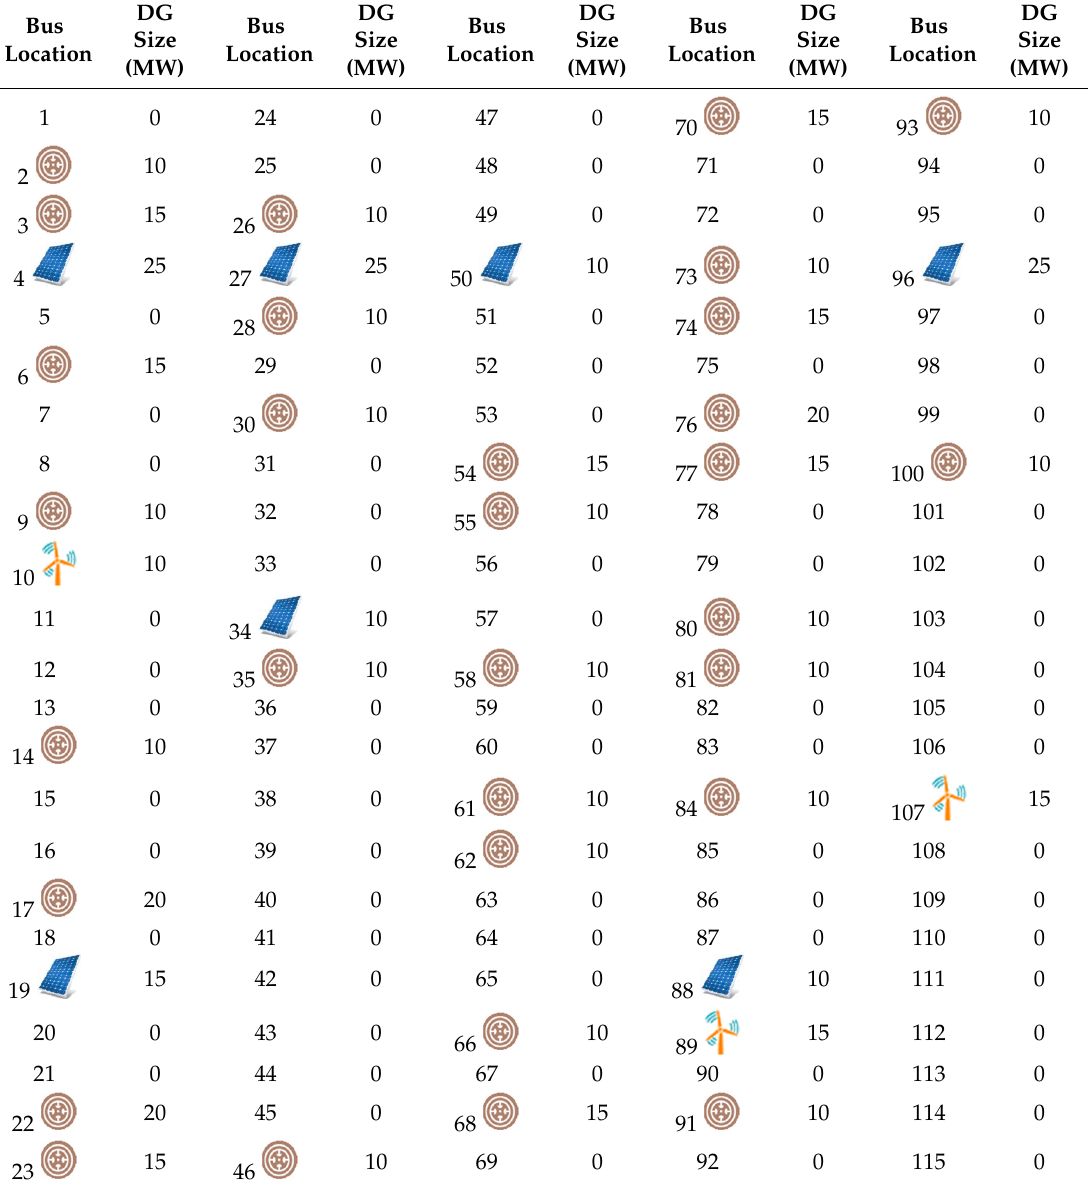
Table 6. Optimal size and locations of DG resources.